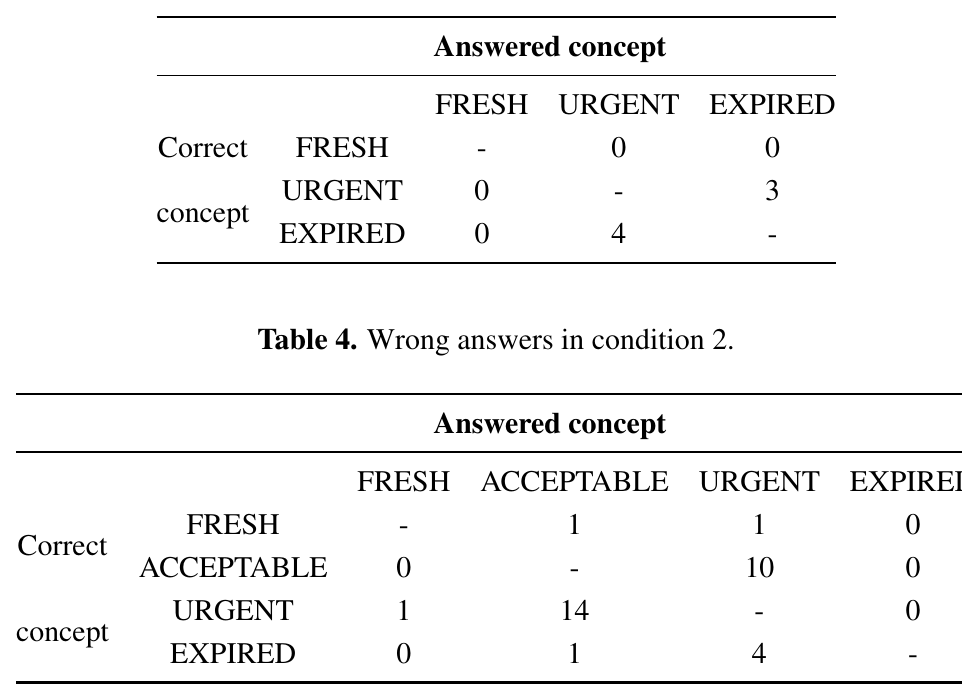
Table 3. Wrong answers in condition 1.